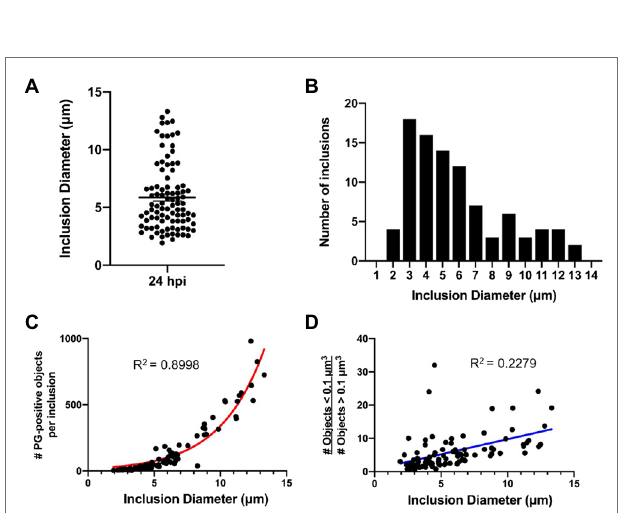
FIGURE 6 | C. trachomatis inclusion diameter is an indicator of the relative maturity of the bacterial population that resides within it. Cell monolayers were infected with C. trachomatis asynchronously, without centrifugation, as described in Figure 1 . (A,B) Diameter measurements were taken for 96 chlamydial inclusions that were fixed and imaged 24 h post-infection. Data are presented as a point spread from the average inclusion diameter (A) as well as via histogram (B) to show the size distribution throughout the population. (C) Inclusion diameter was plotted against the number of PG-positive objects present within each individual inclusion. Data were consistent with a logarithmic growth function (red line). (D) The abundance of low confidence objects (> 0.1 μ m 3 ) to high confidence objects ( ≤ 0.1 μ m 3 ) was plotted as a function of inclusion diameter. Data were inconsistent with a linear regression (blue